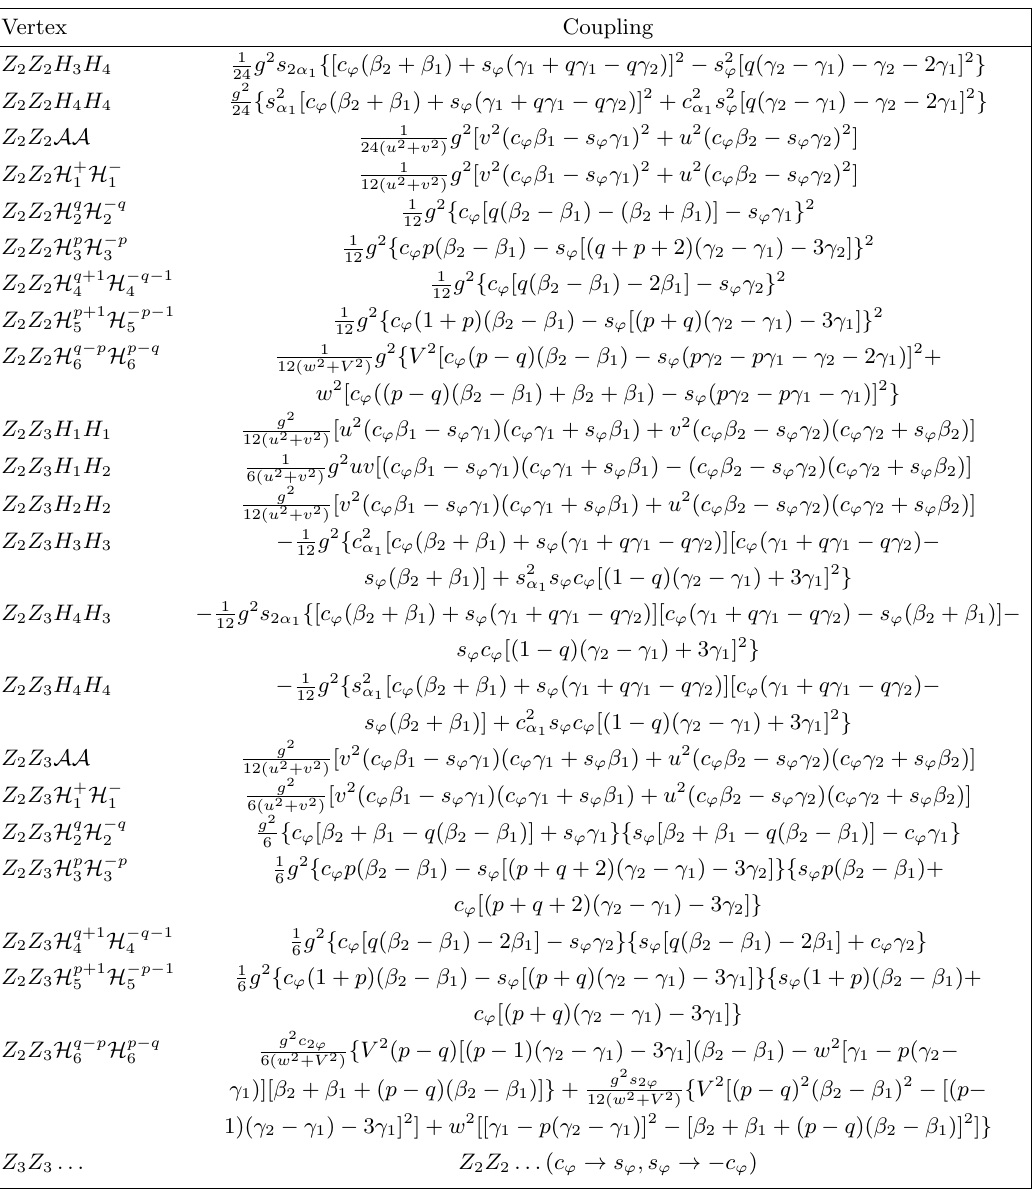
Table 18 . The interactions of two neutral gauge bosons with two scalars (Continued). Open